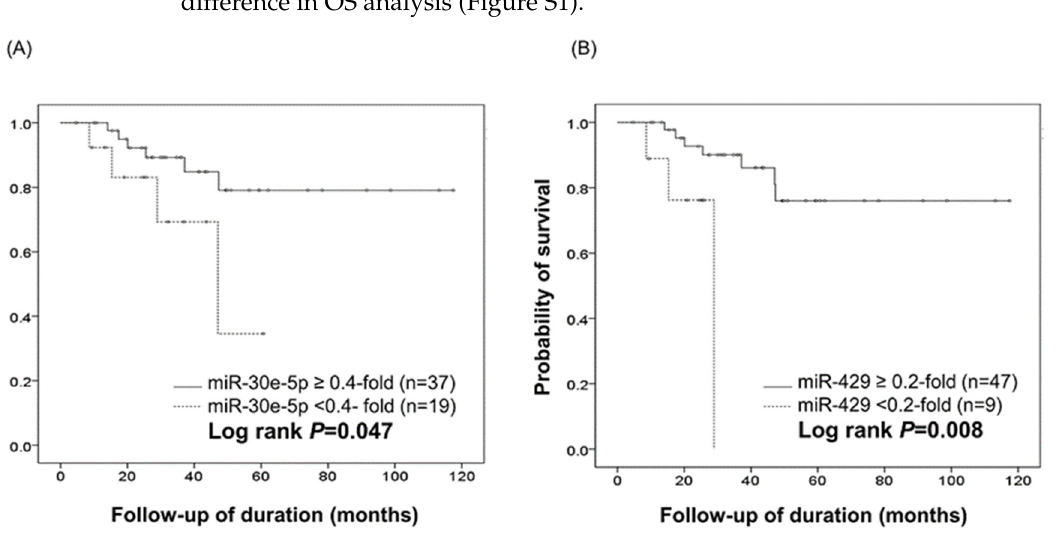
Figure 3. Kaplan–Meier survival curves according to miR-30e-5p ( A ) and miR-429 ( B ) expression in 56 cases of cervical SqCC. Downregulation of miR-30e-5p (<0.4-fold relative to the normal epithelium (NC) level) and miR-429 (<0.2-fold relative to the NC level) each correlates with shorter overall survival with statistical significance (log rank = 0.047 and 0.008, respectively).